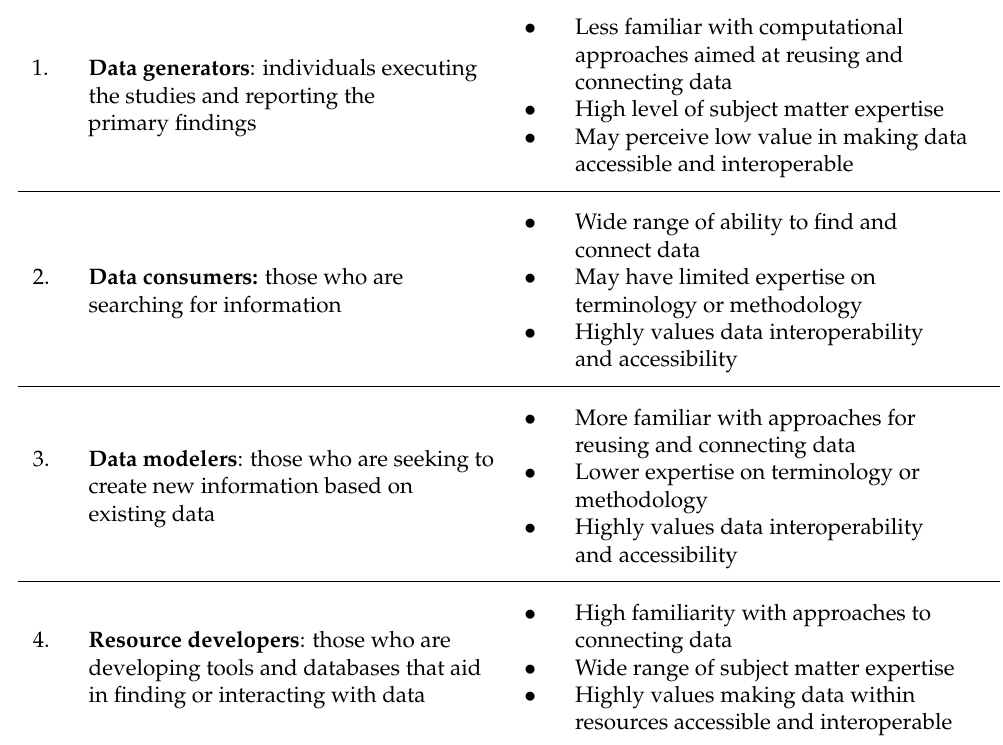
Table 2. Key “actors” or stakeholders identified during